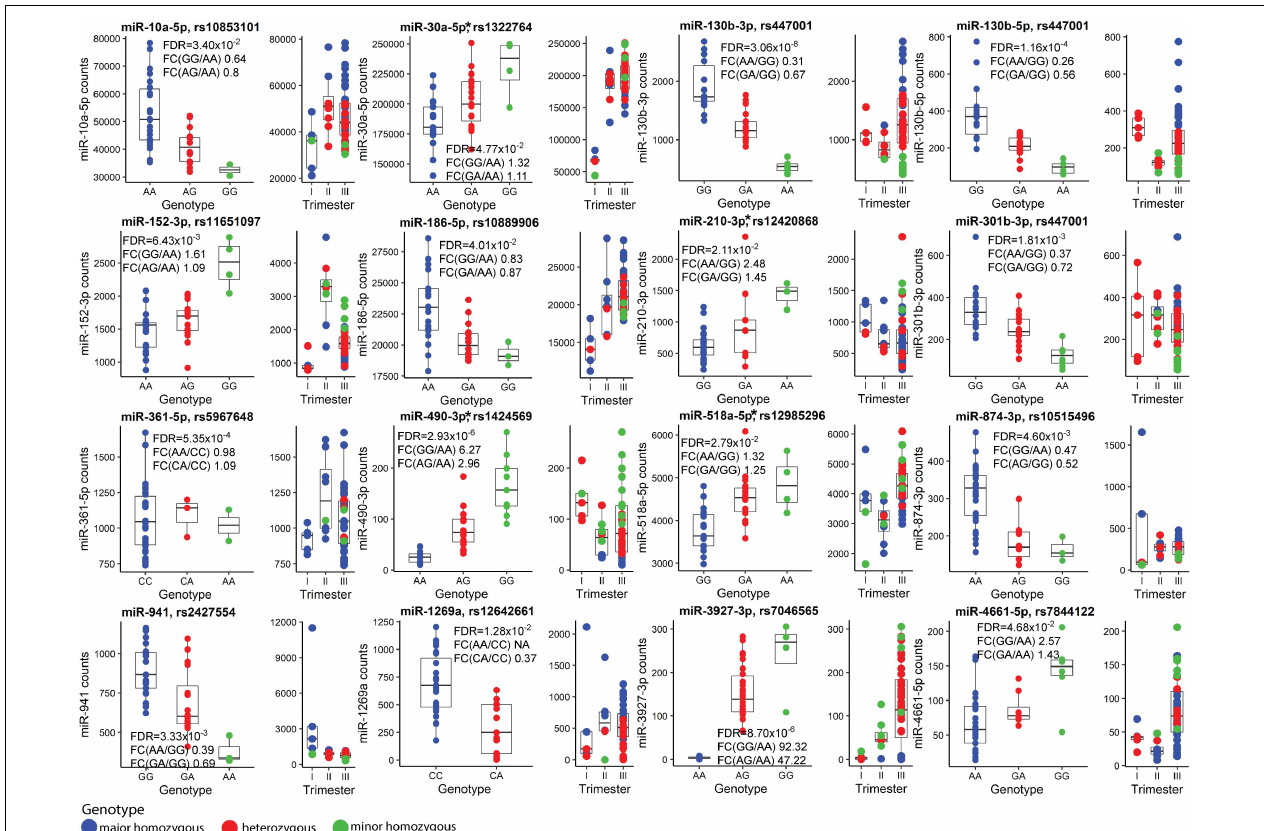
FIGURE 6 | Placental miRNA expression Quantitative Trait Loci (miR-eQTLs). Discovery analysis of single nucleotide variants (SNVs) modulating the expression of flanking miRNAs was carried out in 40 term placental samples and the most significant miR-eQTLs are presented. In each subgraph, miRNA normalized read counts ( y -axis) are shown for samples stratified based on SNV genotypes ( x -axis). Blue, red and green colors represent placentas homozygous for the major allele, heterozygous or homozygous for the minor allele of SNV, respectively. Additionally, distribution of genotype-stratified samples in the trimesters are shown. miRNAs that are also differentially expressed in term preeclampsia are indicated with an asterisk (*). Further details are presented in Supplementary Tables 1 , 21 , 33 and Supplementary Data 1 . FDR, false discovery rate; FC, fold change.